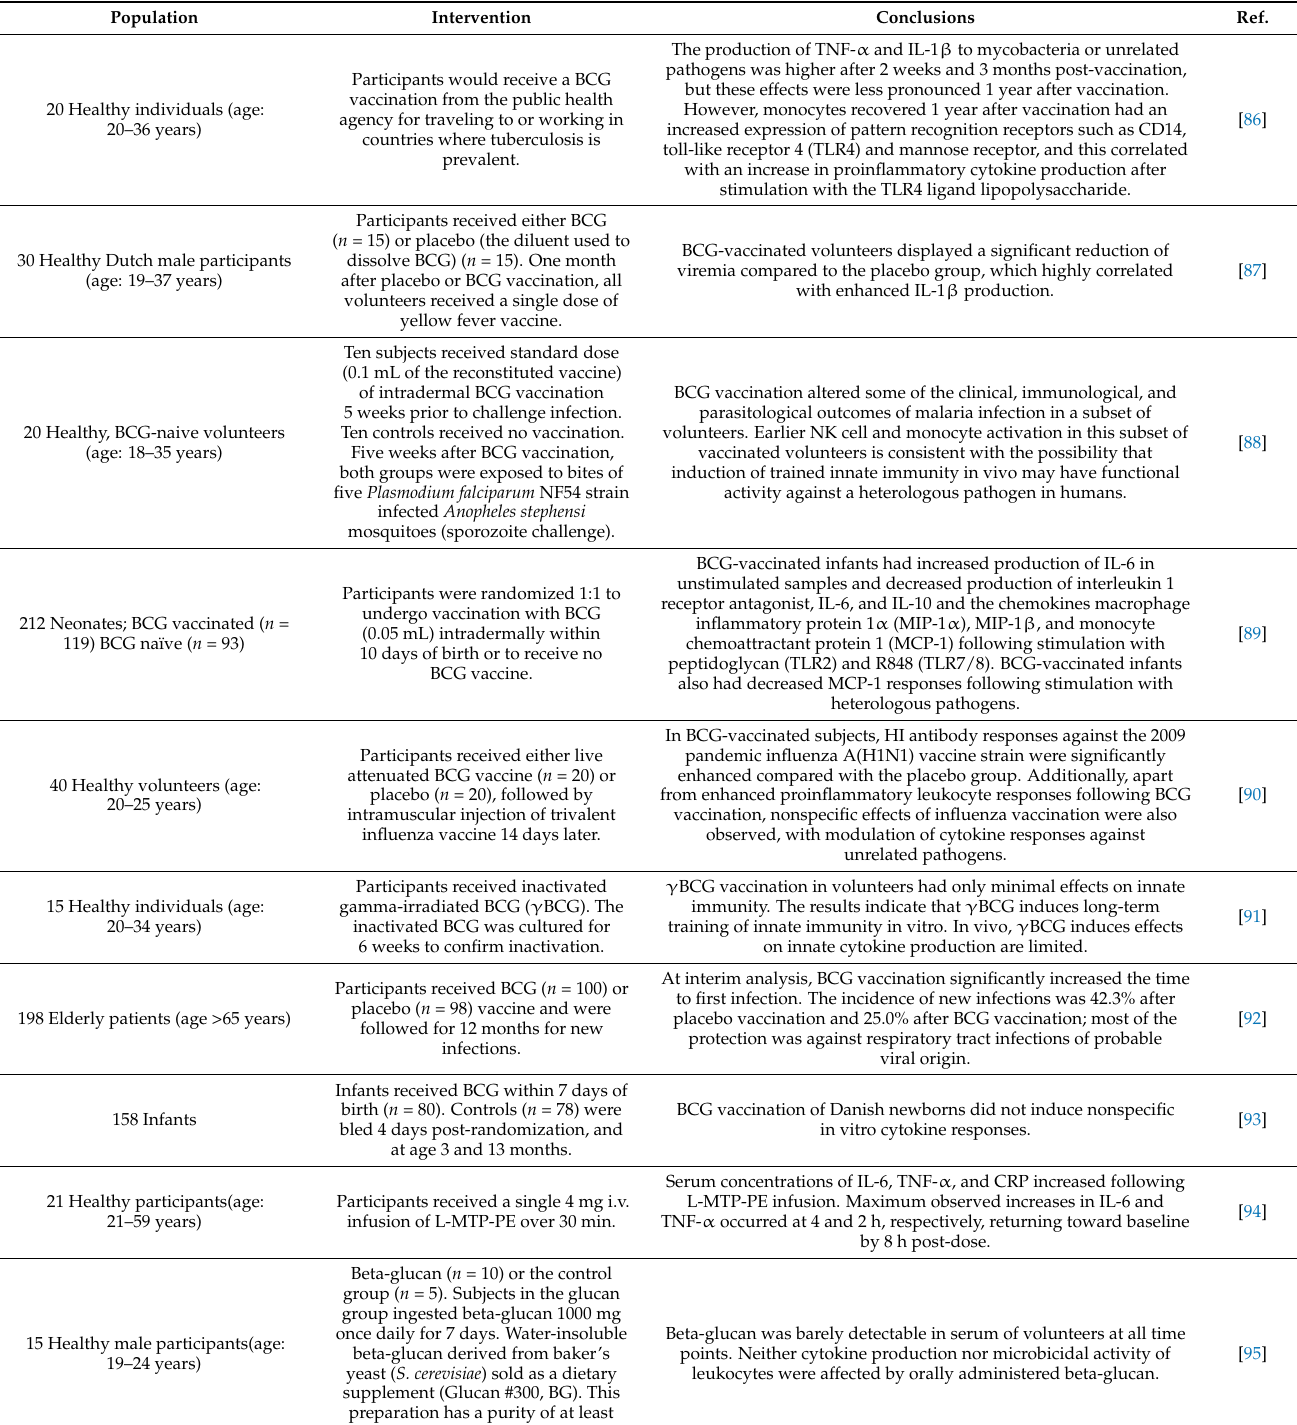
Table 3. Clinical trials on trained